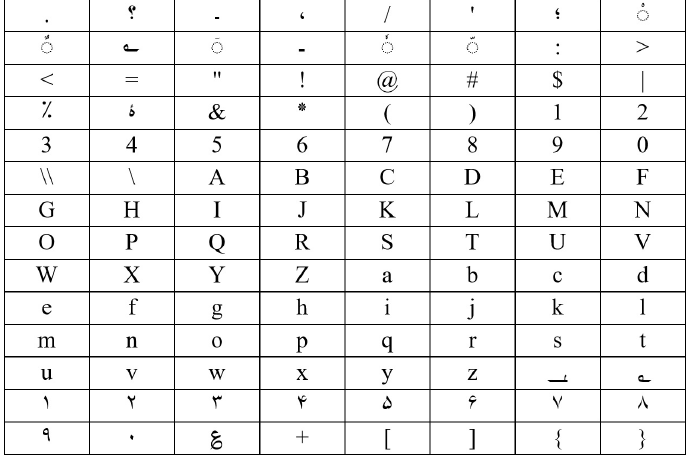
Figure 2. Noise removed while dataset